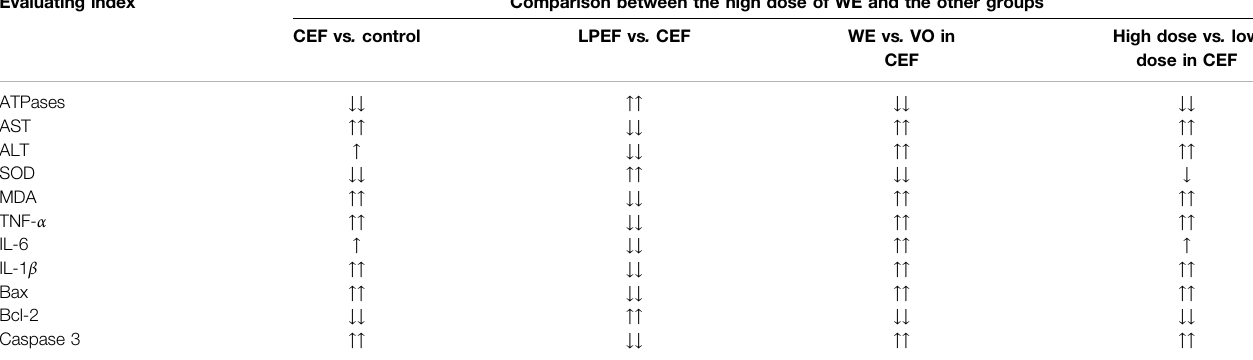
TABLE5| Changingtrendsandsigni fi canceresultsoftheeffectsofthedrugsonthetoxicologicalindexes,takingthehigh-dosegroupsofCEFandLPEFwaterextracts(WE) for example. Evaluating index Comparison between the high dose of WE and the other groups CEF vs . control LPEF vs . CEF WE vs . VO in